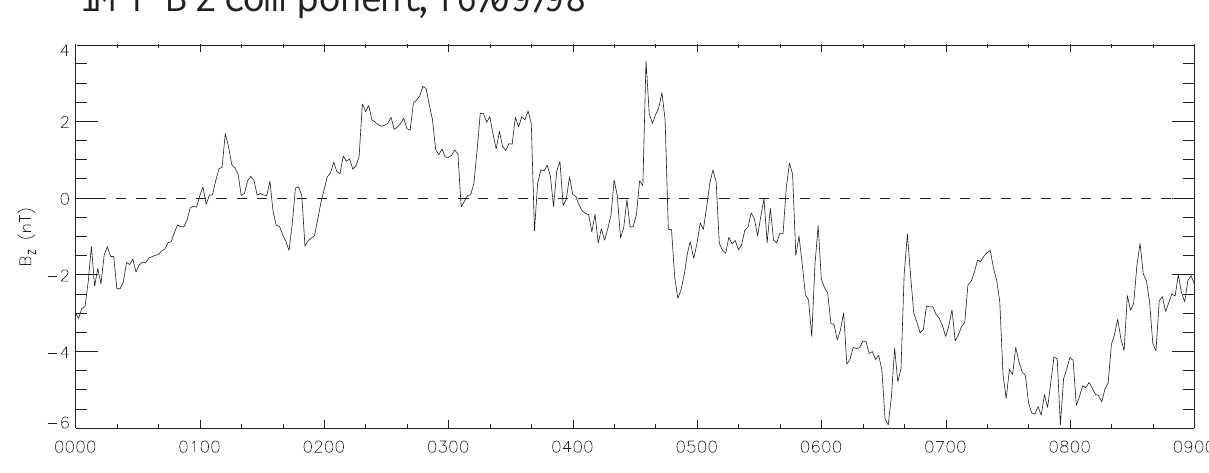
Fig. 3. The IMF B z component measured by the WIND spacecraft for the period 00:00 to 09:00UT. A 75-min lag time has been added onto the time scale of the plot, representing the delay between the IMF being observed by the satellite and when it impinges on the